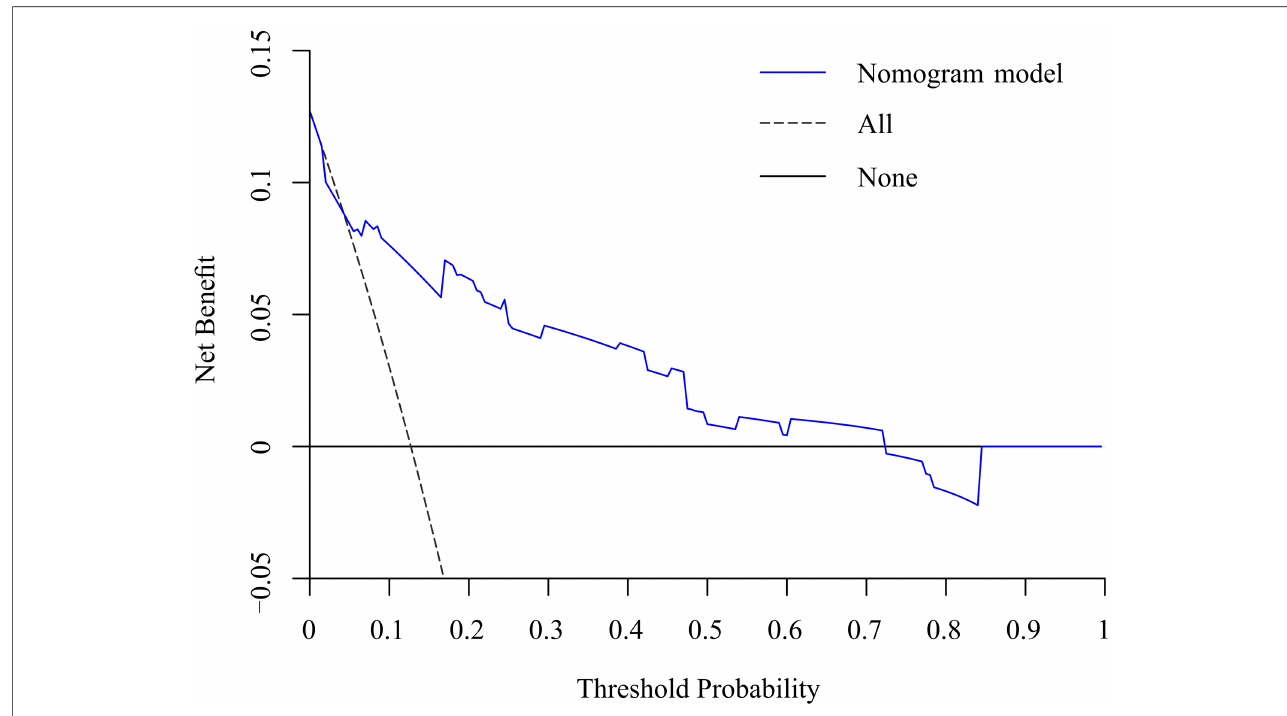
FIGURE 8 DCA curve of the nomogram for the assessment of clinical practice based on the net bene fi t and threshold probabilities.